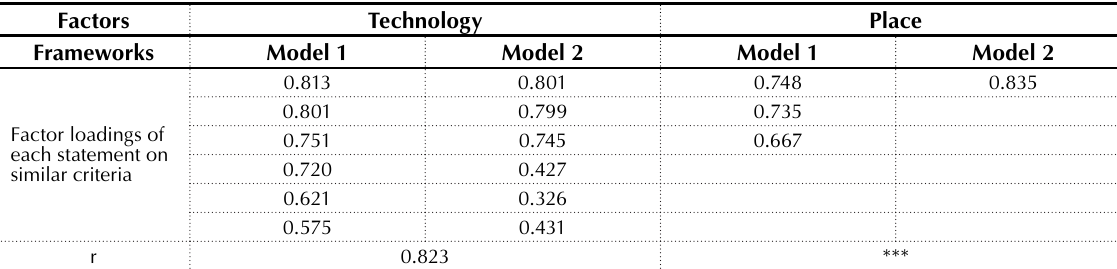
Table 3. Pearson correlation coefficients between common factors